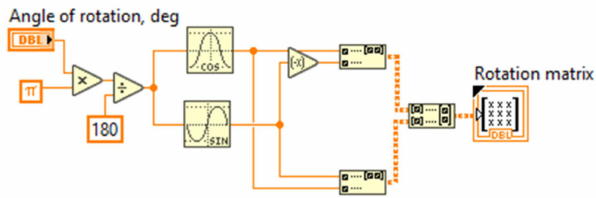
Figure 13. Program code in LabVIEW to form a rotation matrix.